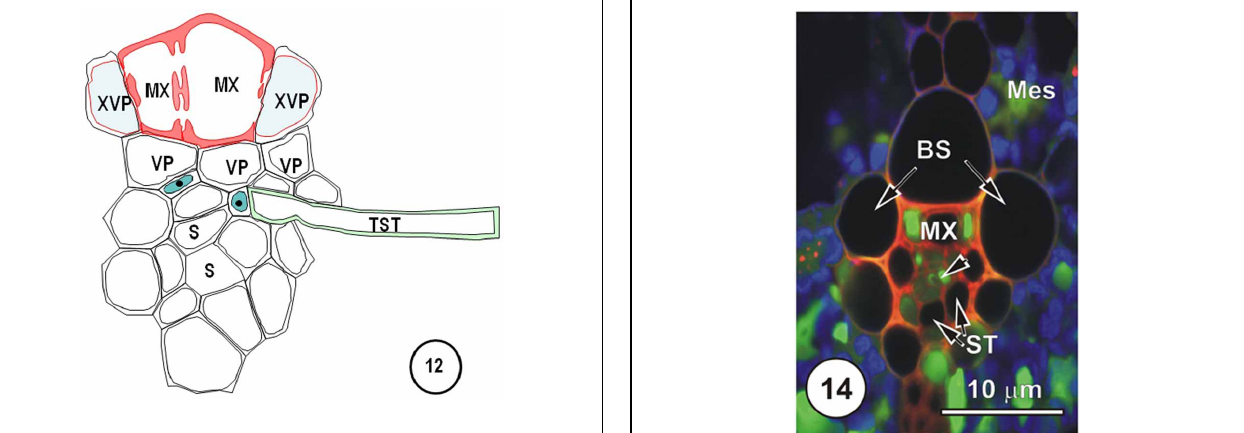
FIGURE 12 | Diagram redrawn and interpreted from Figure 10, showing a thick-walled sieve tube (blue fill, solid dot) connection to a transverse vein TST (left). The emergences of a transverse vein ST from its longitudinal vein connection. XVPs (with half-bordered pit-pairs) about the xylem (MX) and vascular parenchyma (VP) are in association with the TSTs.